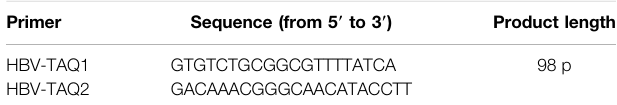
TABLE 1 | The primers used in quantitative polymerase chain reaction (qPCR) reaction.